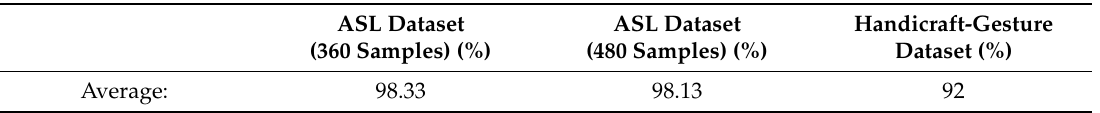
Table 5. Recognition accuracies (%) for the three datasets by using the Leave-One-Out cross-validation method.